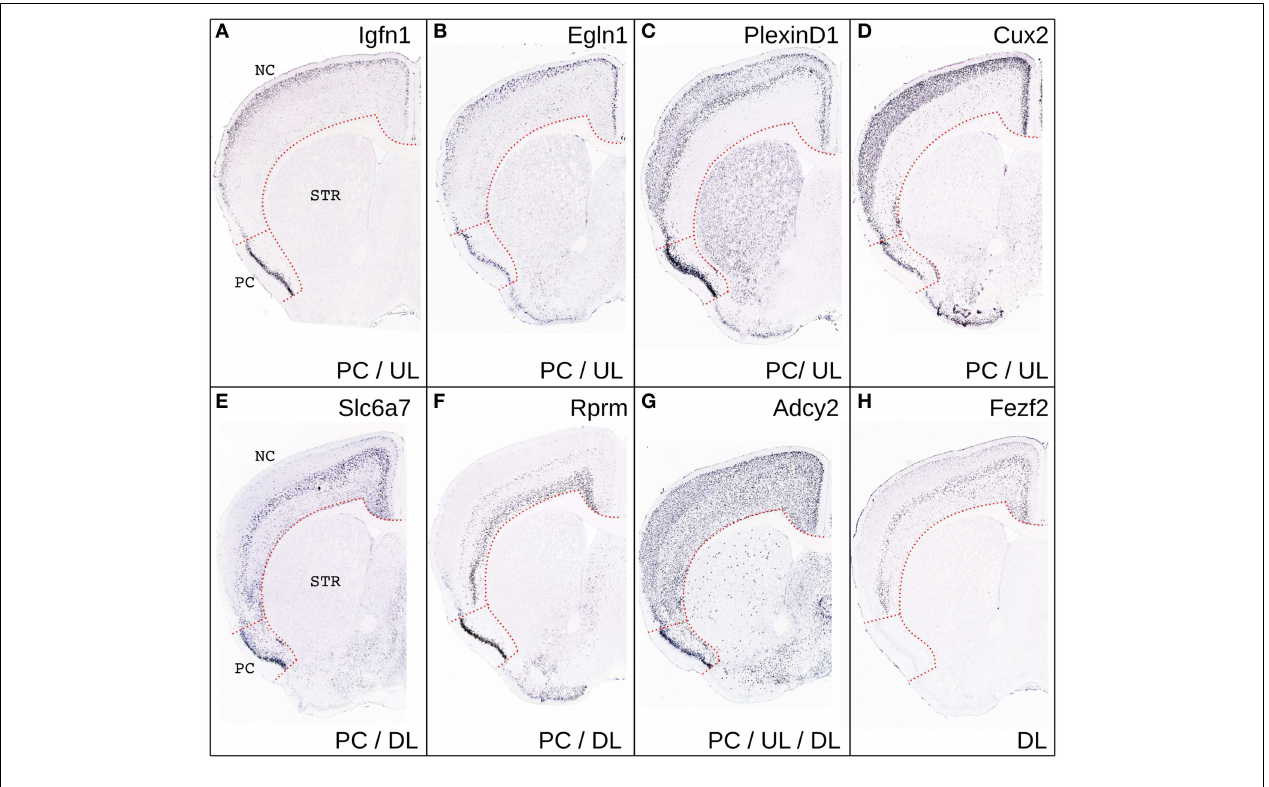
FIGURE 3 | Comparison of gene expression in PC and NC. Representative coronal sections from the Allen Brain Atlas showing the expression of few representative genes selectively enriched in the UL and PC (A–D) , in DL and PC (E,F) in DL, UL and PC